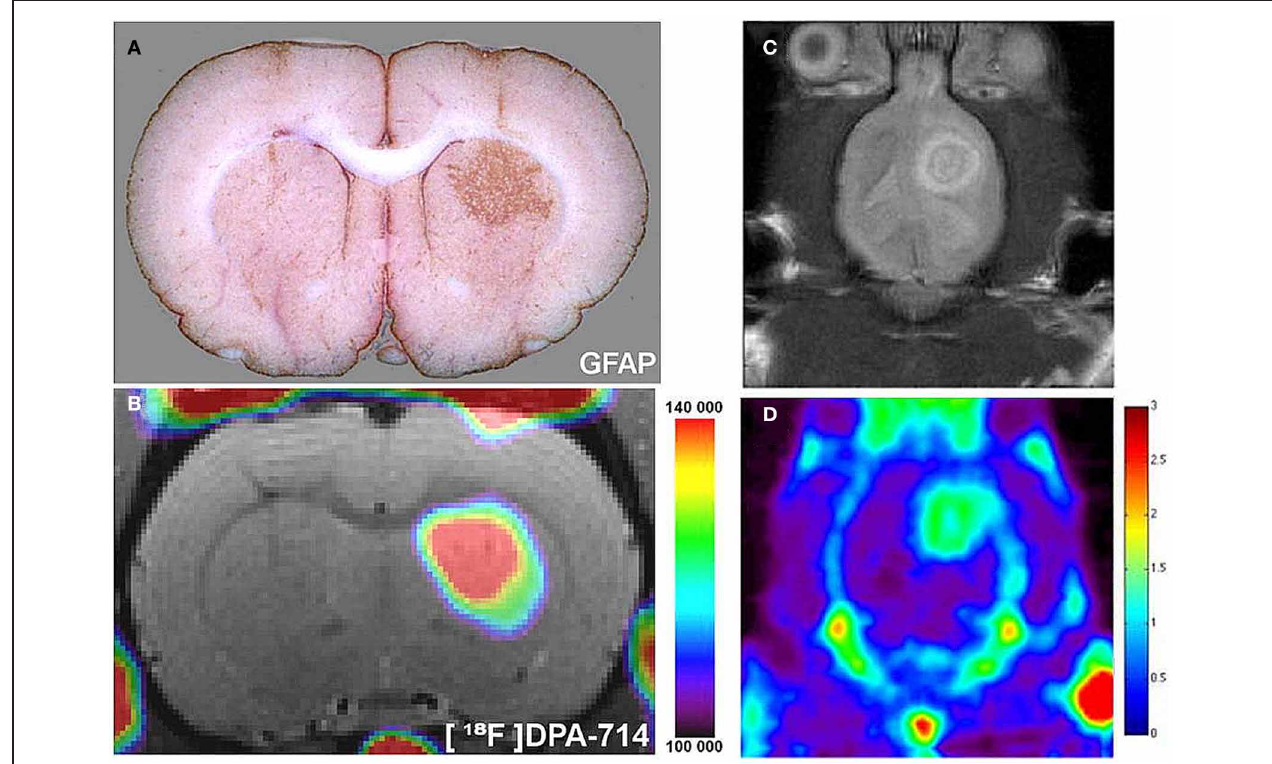
FIGURE 2 | Radiolabeled TSPO ligands can be used to image astrocyte activation in vivo . (A) In a rat model, astrocytes were chronically activated (GFAP staining, brown) by lentiviral gene transfer of the cytokine ciliary neurotrophic factor (CNTF). (B) 18 F-labeled DPA-714, a TSPO ligand, binding spatially correlates with areas of astrocyte activation, as observed with